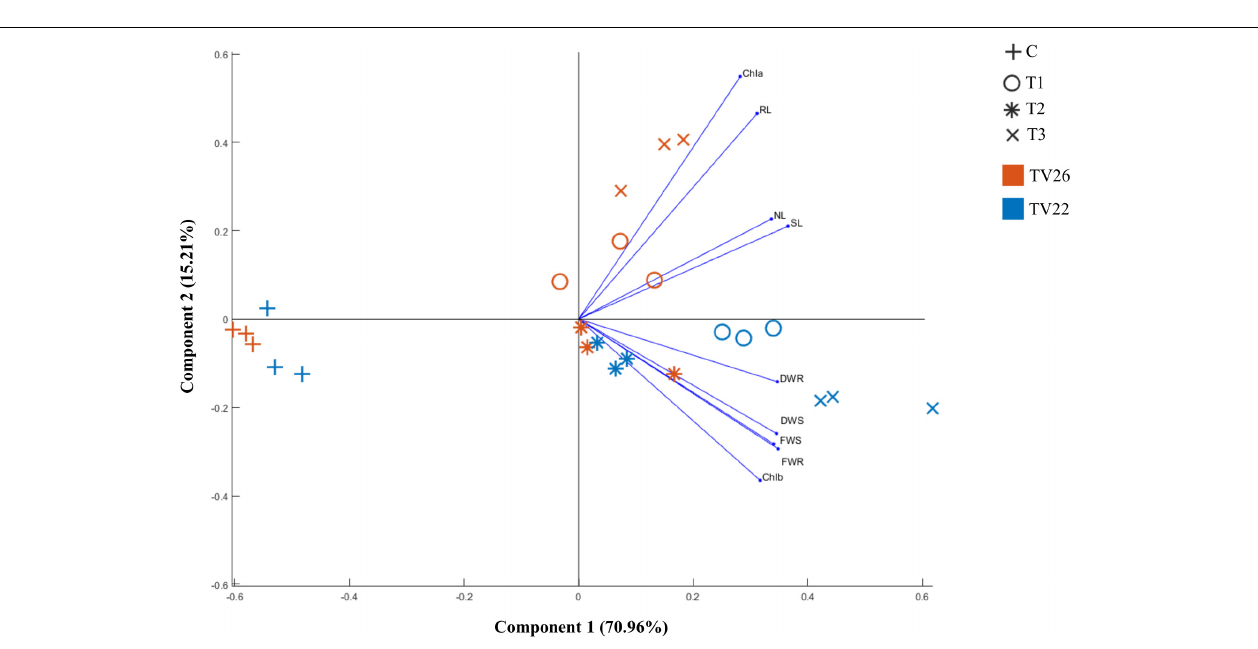
FIGURE 7 | Evaluation of PGP experiment to show the effect of treatments of endophytic bacterial inoculum in two tea clones TV22 and TV26 for (A) shoot length; (B) root length; (C) number of leaves (D) fresh weight shoot; (E) fresh weight root; (F) dry weight shoot; (G) dry weight root; (H) chlorophyll a; and (I) chlorophyll b. Error bar represents the standard error of means of replicates ( ∗ p < 0.05, ∗∗ p < 0.01, ∗∗∗ p < 0.001).